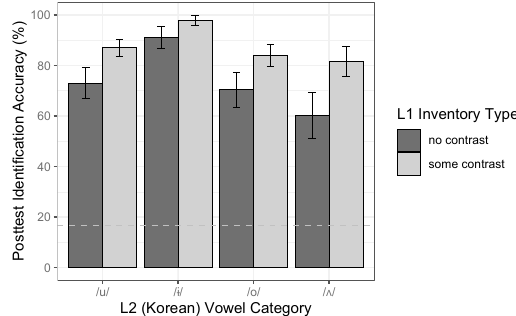
Figure 8. Posttest performance in the vowel study (accuracy in 6AFC identification), by L2 vowel category and L1 group (i.e., vowel inventory type). Error bars indicate SE of the mean over participants; the dotted line marks chance-level performance (17%). Table 7. Fixed-e ff ect coe ffi cients in the final model of posttest vowel identification [ N = 684,